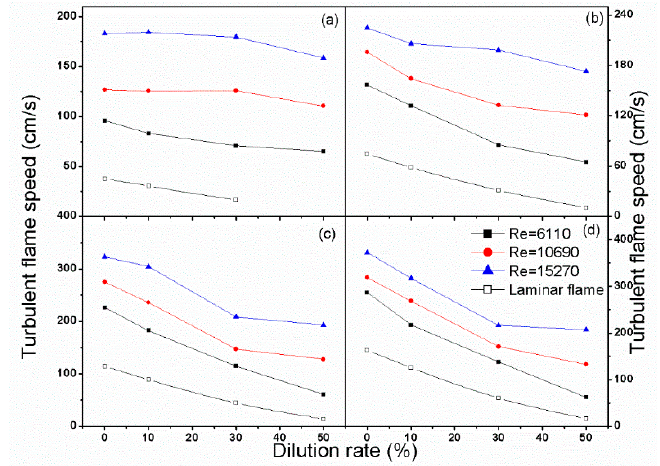
Figure 15. Trend in the turbulent flame velocity of syngas with different hydrogen proportions under different nitrogen dilution rates and exit Reynolds numbers: ( a ) 5%; ( b ) 25%; ( c ) 50%; ( d ) 75% hydrogen volumetric proportion.